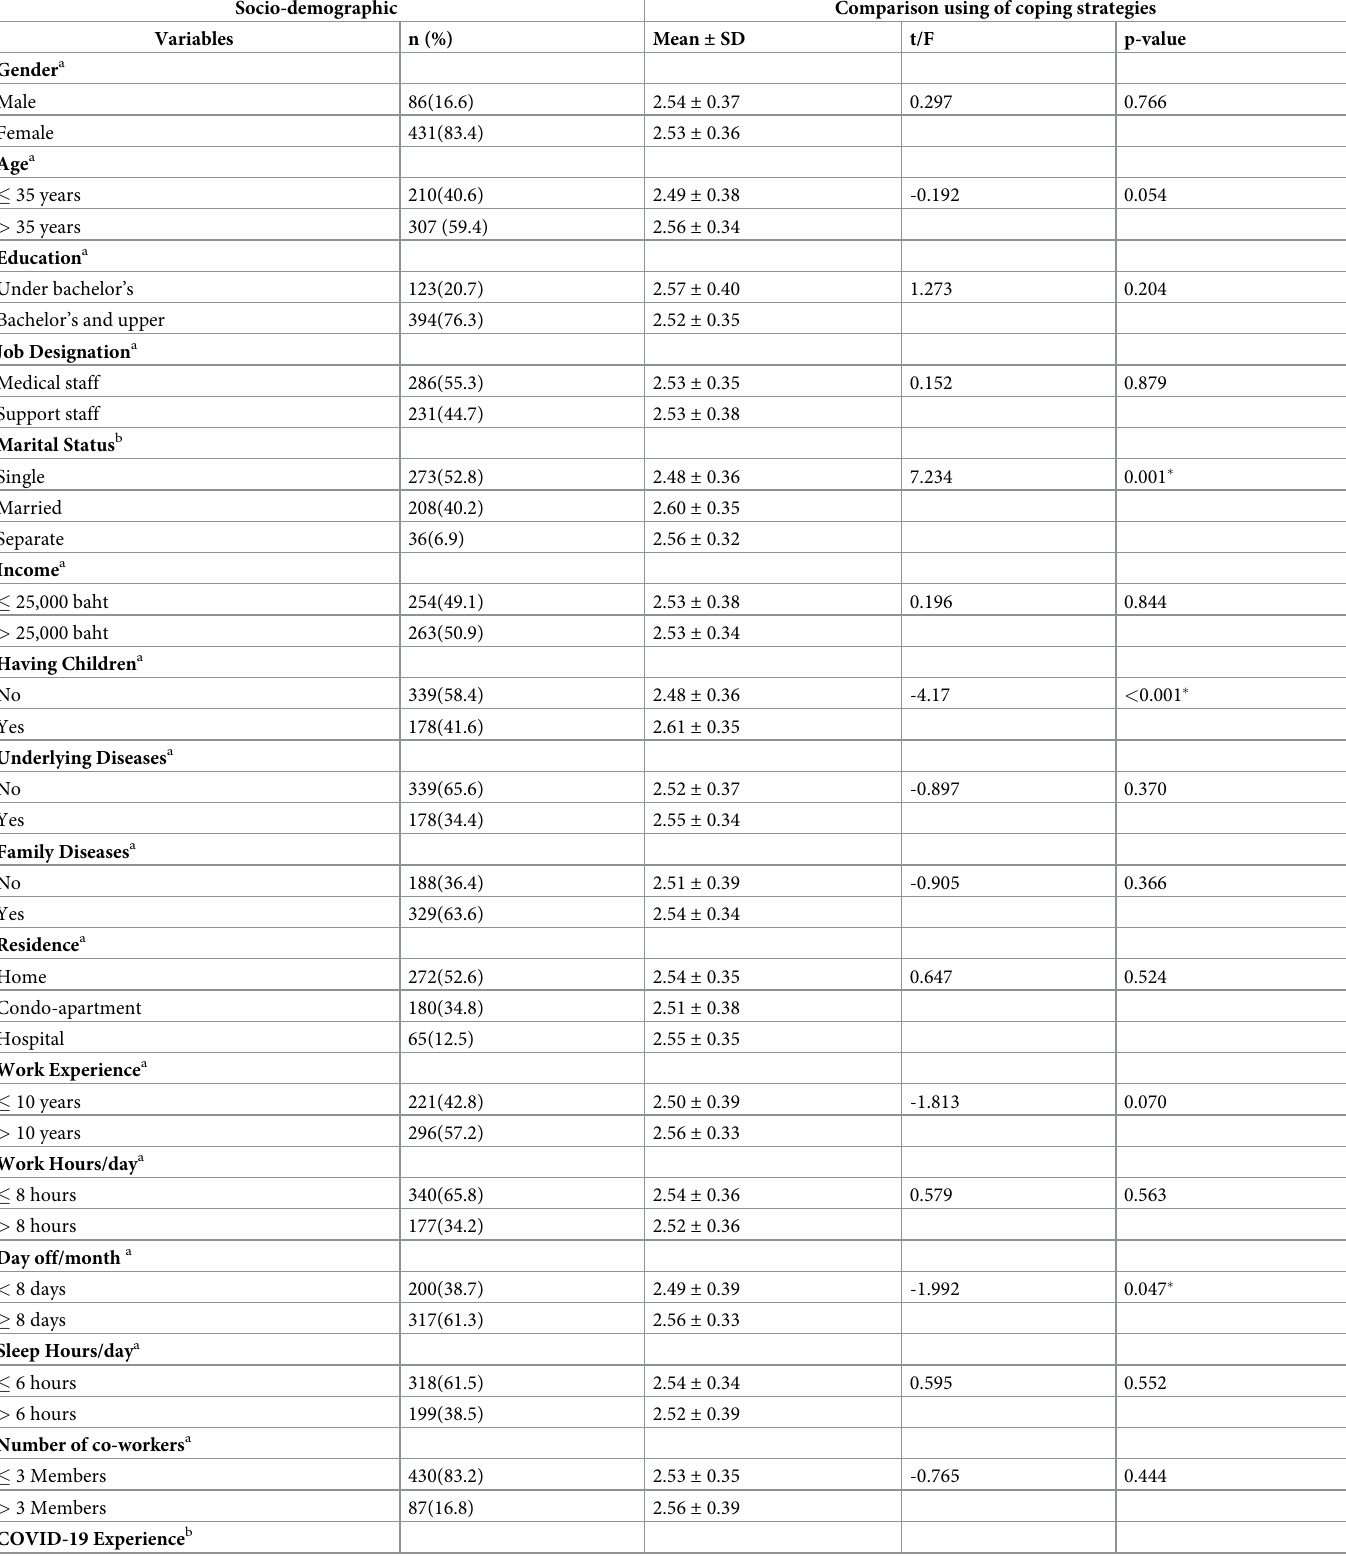
Table 1. Socio-demographic and comparison of coping strategies (Brief-COPE score) among HCWs during COVID-19 (n =